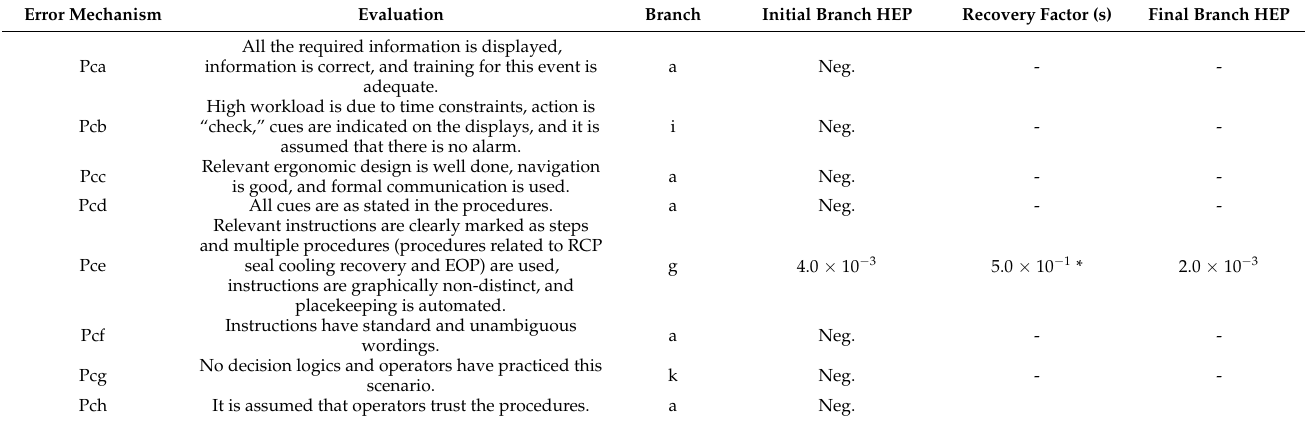
Table 9. Evaluating the diagnosis error for operator failure to start the charging pump for RCP sealing. Error Mechanism